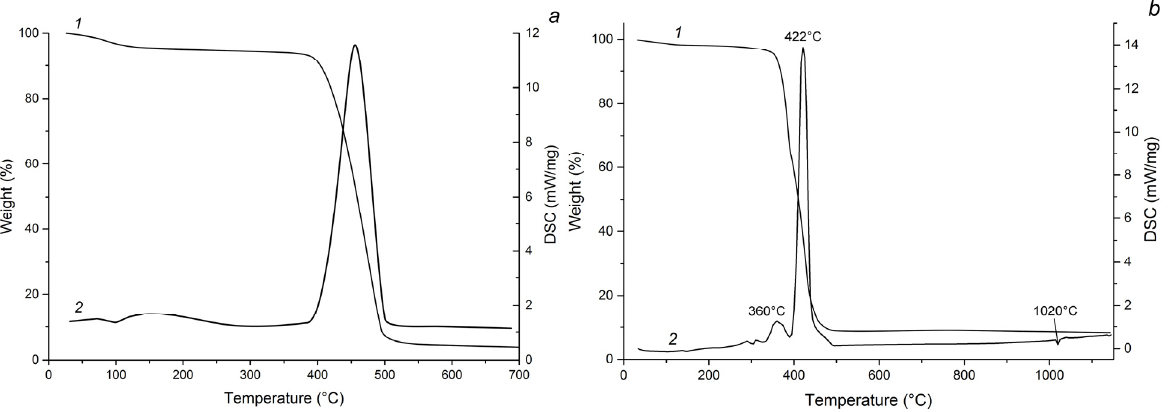
Figure 9. SEM ( a , c ) and EDS ( b , d ) of PVI ( a , b ) and nanocomposite 4 ( c , d ). The resistance of PVI and nanocomposites to thermal oxidative destruction was studied by TGA and DSC methods. According to thermogravimetric analysis, the thermal stability of the initial poly-N-vinylimidazole is 380 °C (Figure 10a). Complete combustion of PVI occurs at 530 °C.